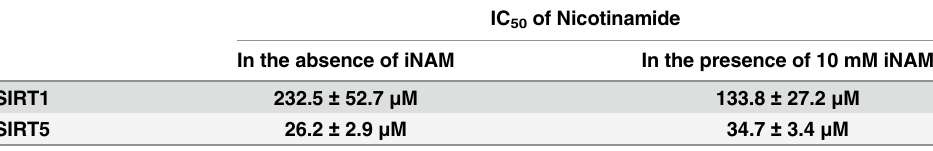
Table 4. Isonicotinamide (iNAM) Effect on the Nicotinamide Inhibition of SIRT1 and